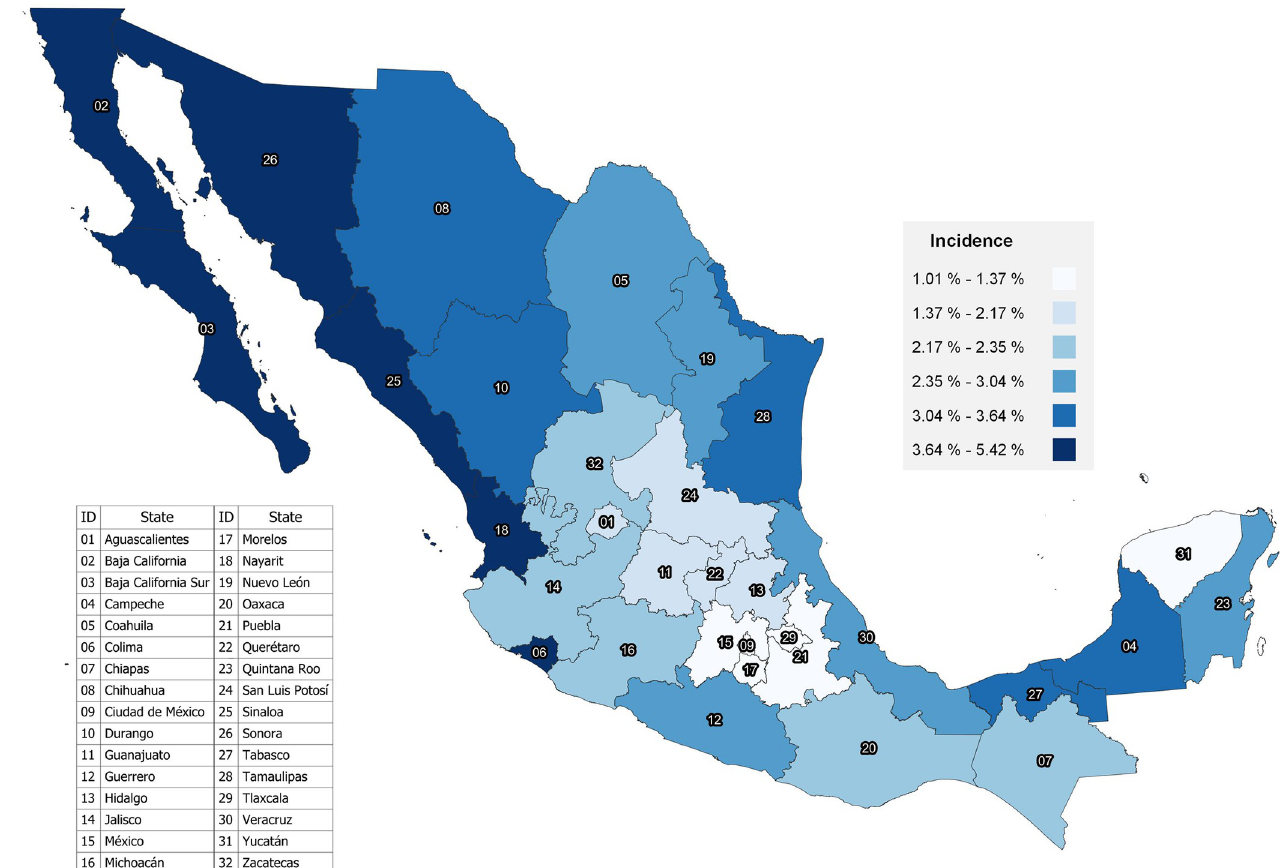
Fig 2. FM incidence in live births in Mexico at the state level in females,